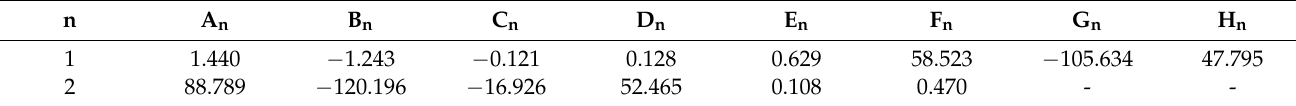
Table A18. Coefficients of the H 2 O-LiCl specific heat